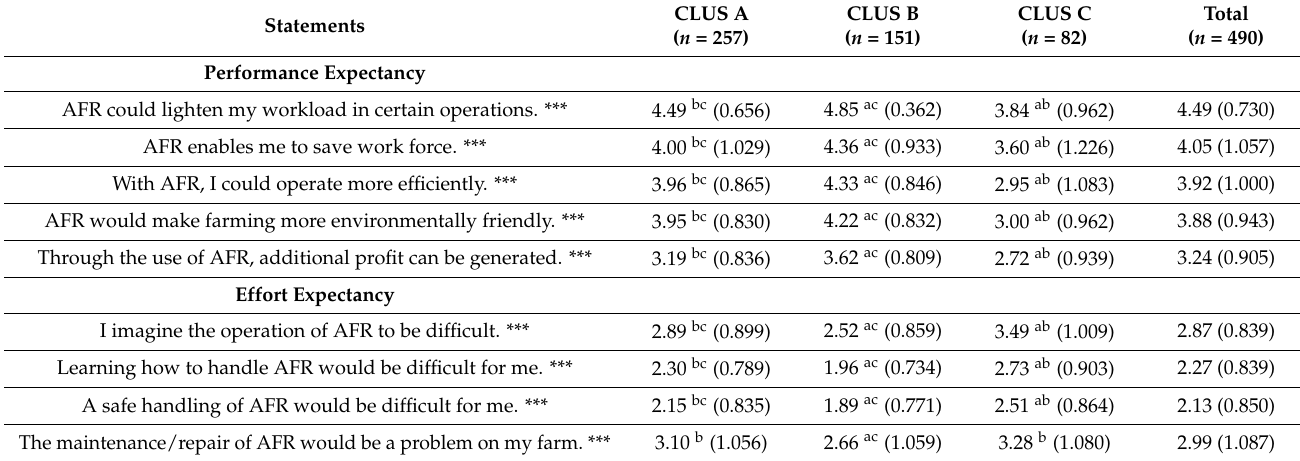
Table 2. Results of the cluster descriptive